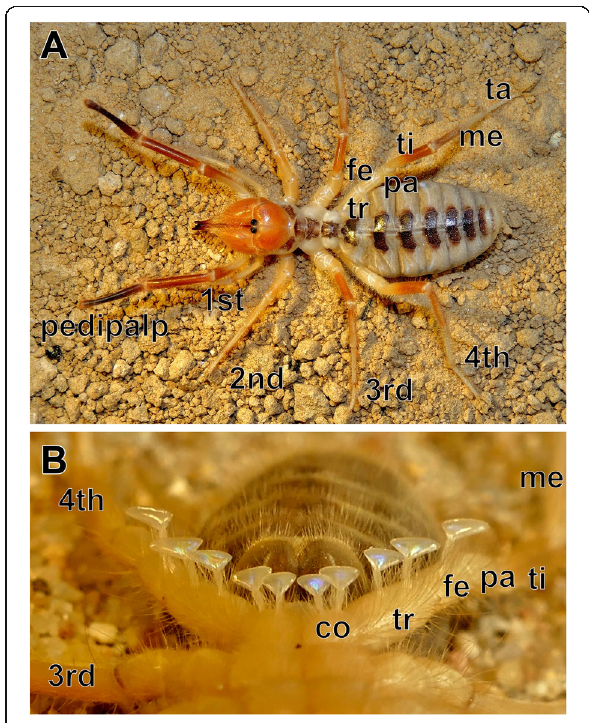
Fig. 1 Camel spiders and their malleoli. a Galeodes arabs , dorsal view. b Anteroventral view of malleoli on the ventral surface of the fourth walking legs. Five malleoli are present on each leg, located on the coxa (or basis; 2 malleoli), trochanter (2 malleoli) and femur (1 malleolus). Abbreviations: co coxa, fe femur, me metatarsus, pa patella, ta tarsus, ti tibia, tr trochanter. Walking legs 1 – 4 are labelled 1st to